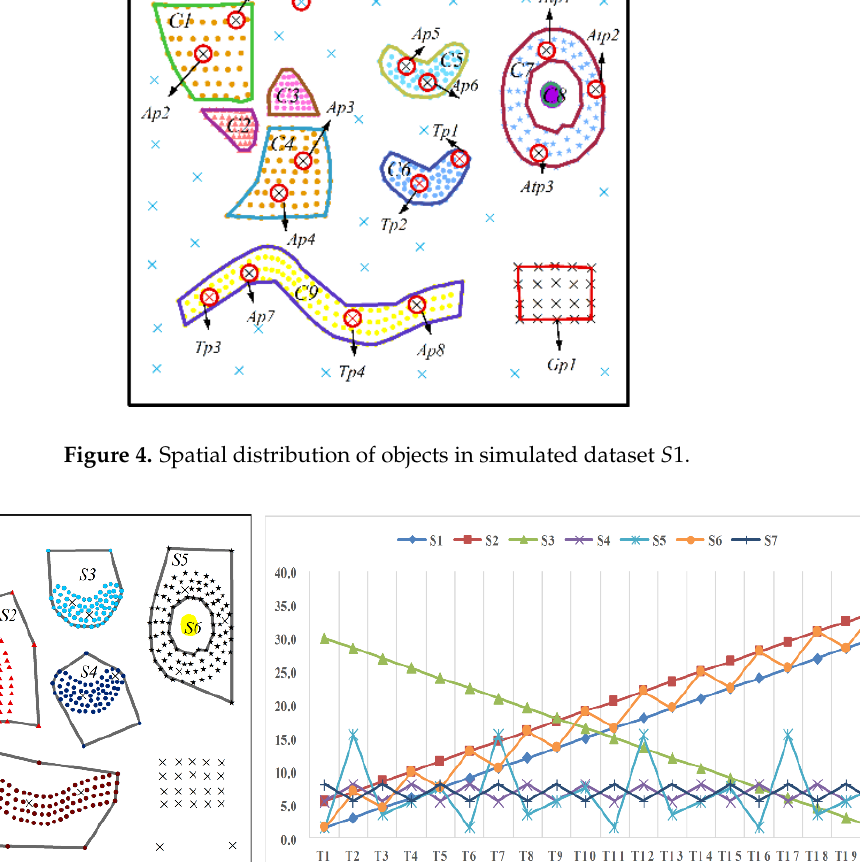
Figure 6. Spatial distribution of clusters and noises in simulated dataset S 2.